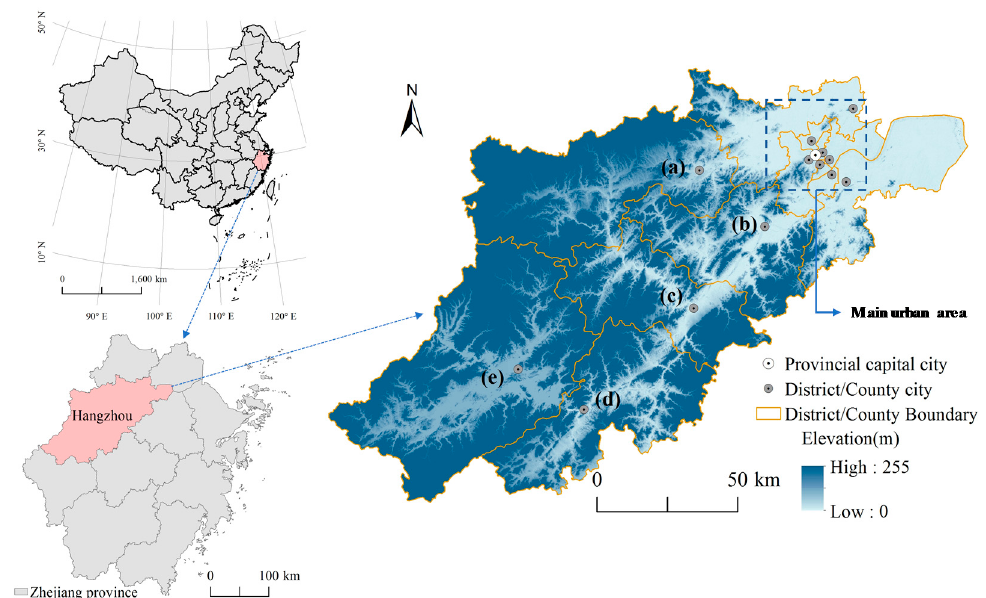
Figure 1. The study area, Hangzhou. Notes: ( a ) Lin’an, ( b ) Fuyang, ( c ) Tonglu, ( d ) Chuan’an, ( e ) Jiande. The main urban area of Hangzhou includes Shangcheng District, Xiacheng District, Xihu District, Gongshu District, Jianggan District, Xiaoshan District, and Yuhang District.